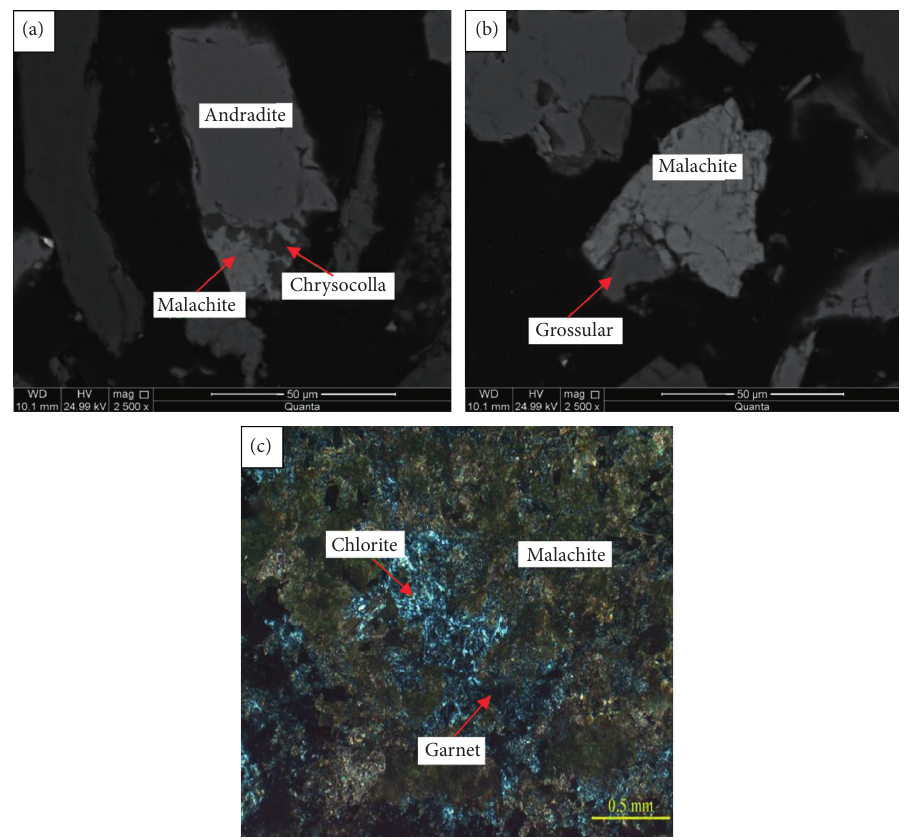
Figure 6: Embedded characteristics of